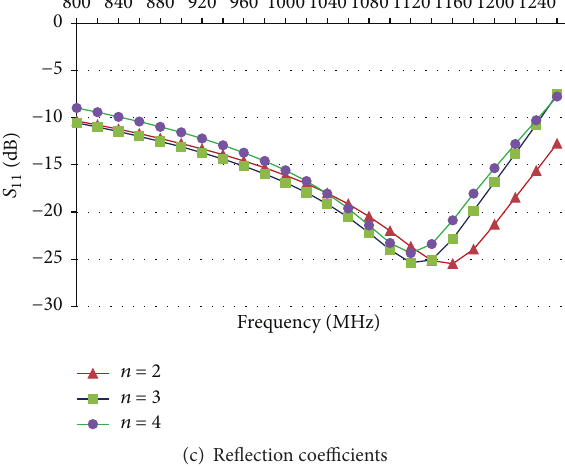
number of meanders are modeled and simulated using